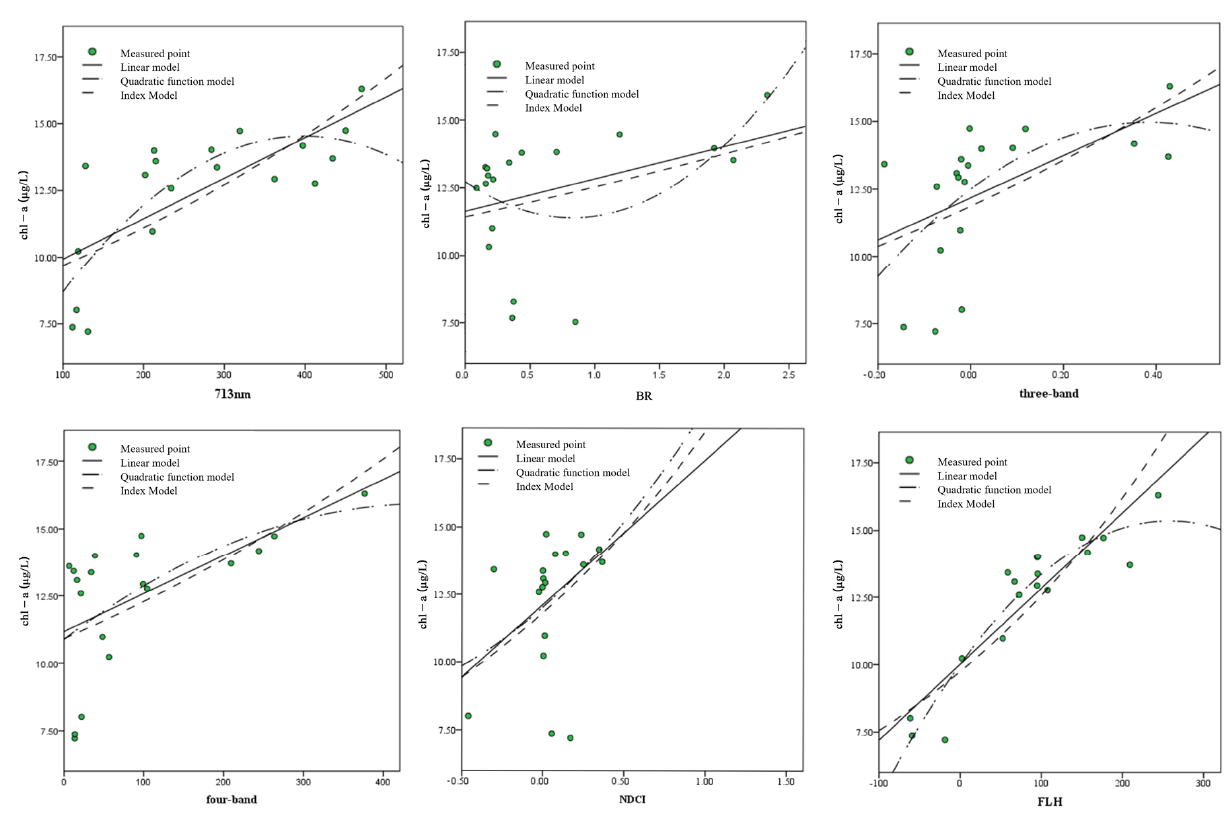
Figure 8. Fitting of the different models to the measured chlorophyll-a concentrations.